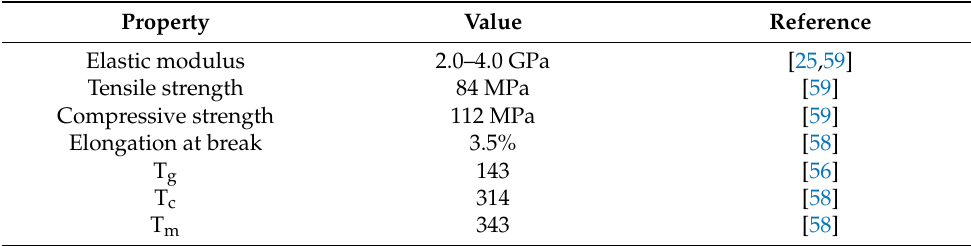
Table 2. PEEK mechanical and thermal properties.